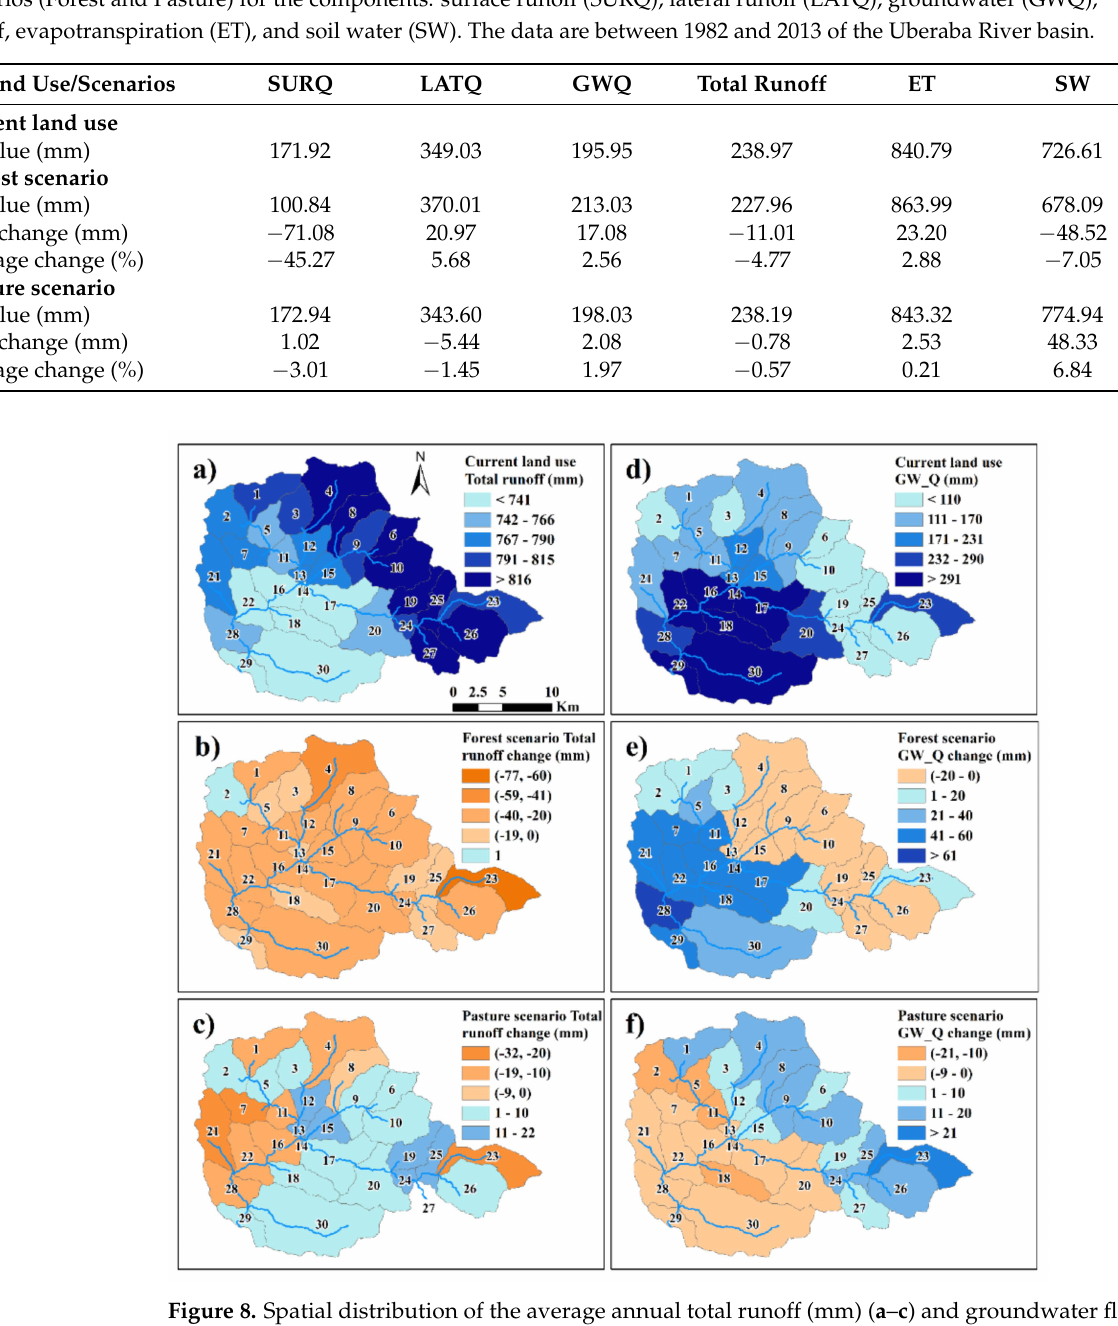
Figure 8. Spatial distribution of the average annual total runoff (mm) ( a – c ) and groundwater flow (GW_Q) (mm) ( d – f ) under current land use ( a , d ), in forest ( b , e ) and pasture ( c , f ) scenarios. The values are expressed in mm and are an average annual between 1982 and 2013 of the Uberaba River